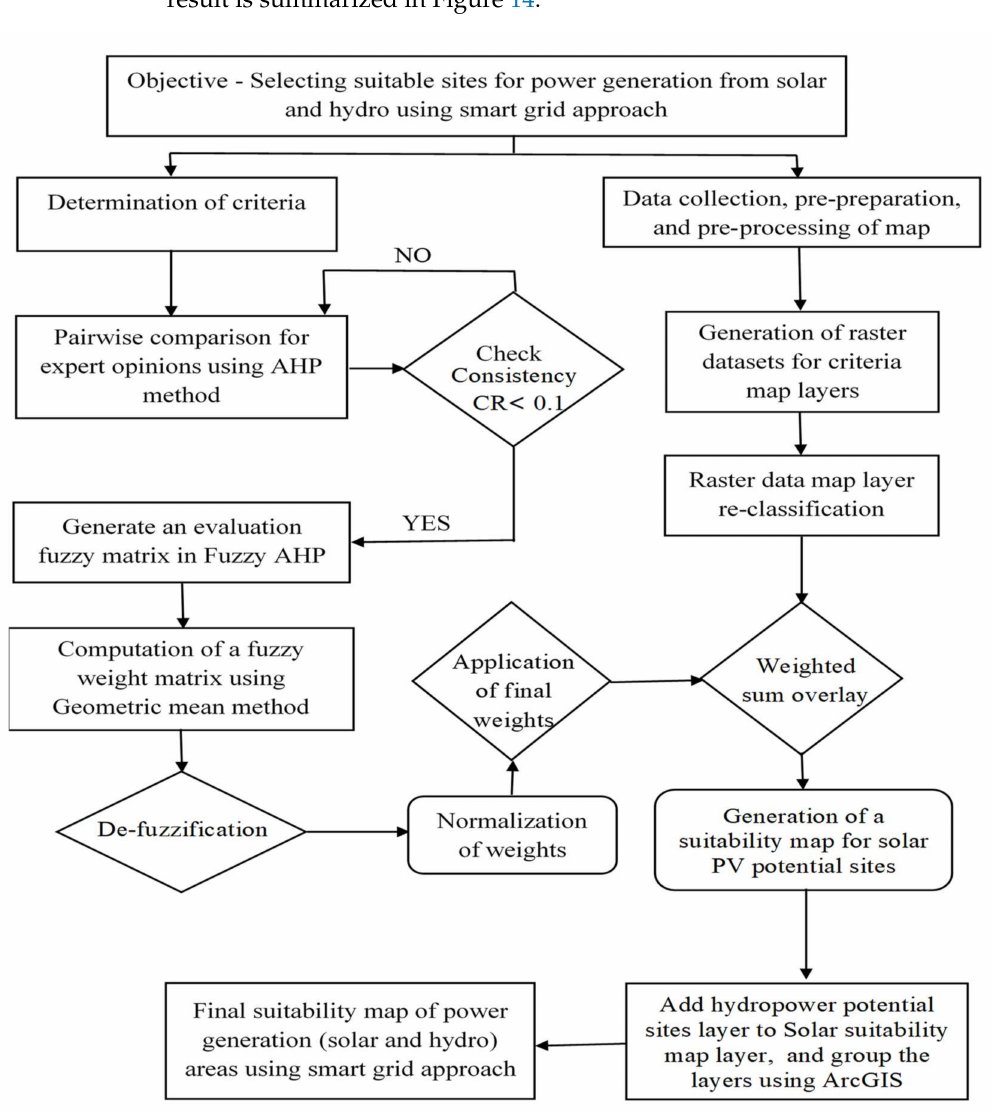
Figure 14. Conceptual flow chart of